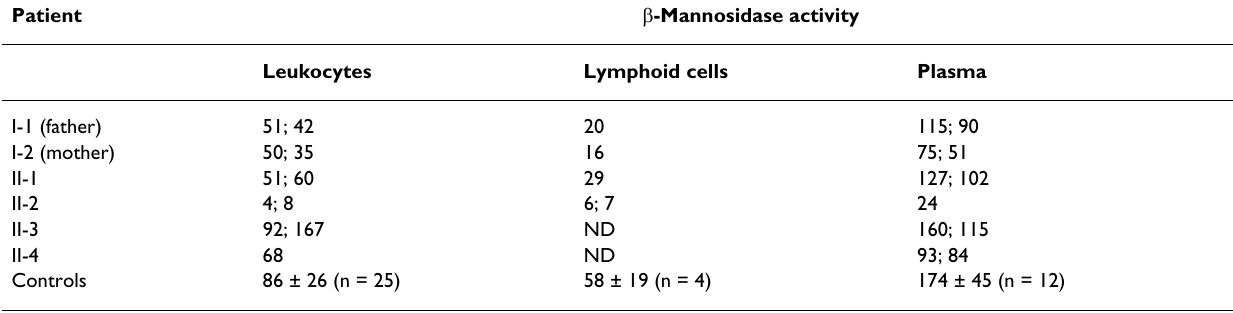
Table 1: β -Mannosidase activity in the